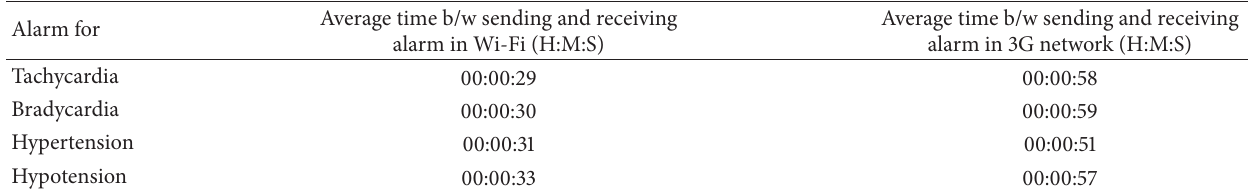
Table 5: Average data transmission time using Wi-Fi and